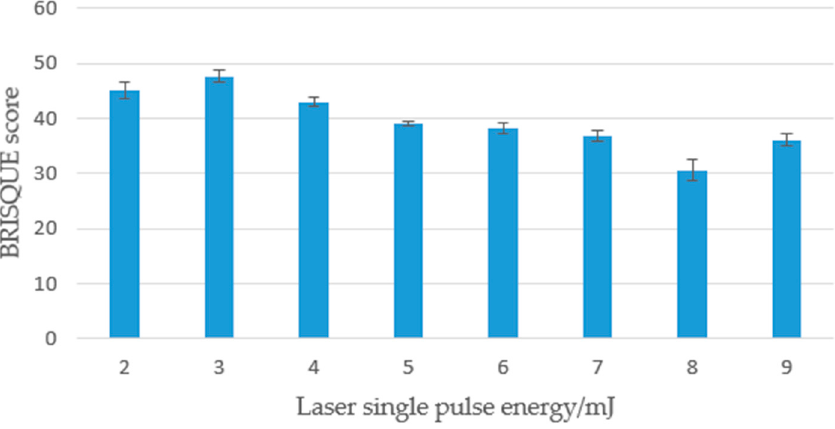
Figure 9. Histogram of laser single-pulse energy and BRISQUE score.